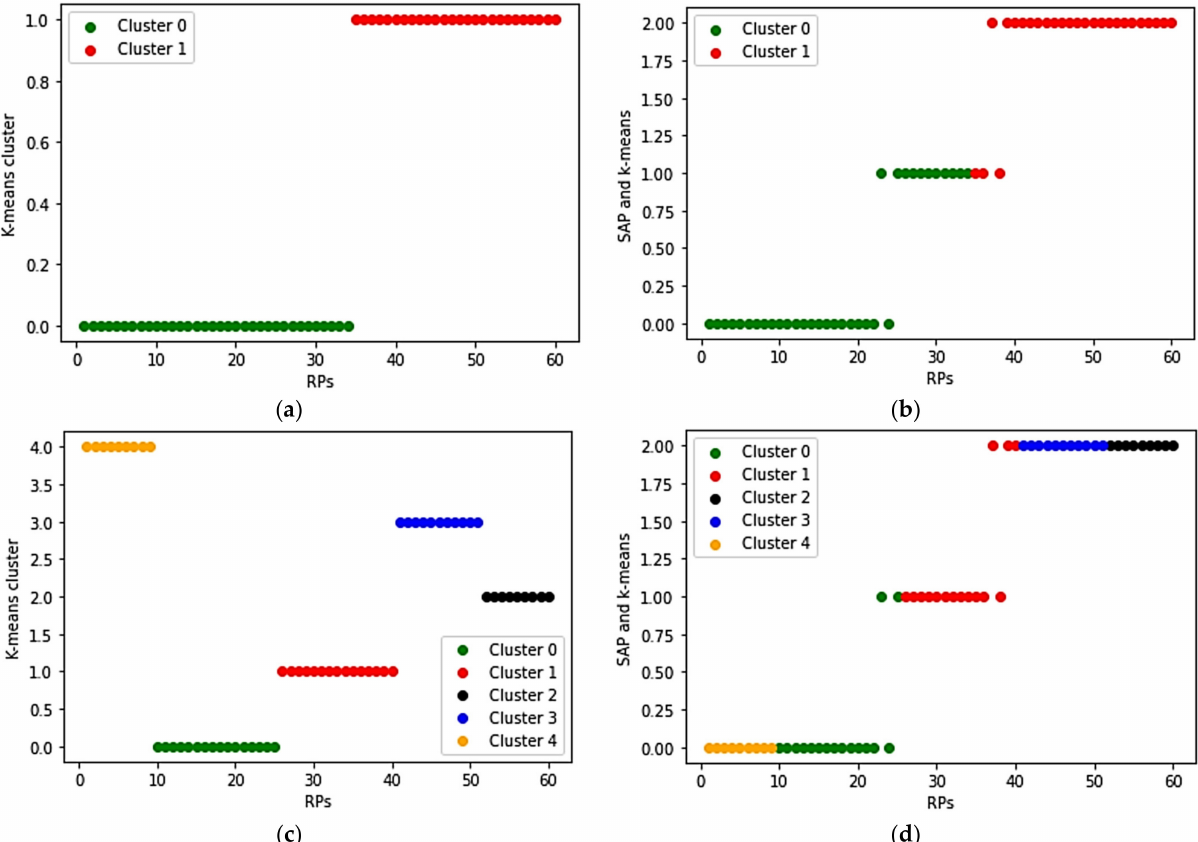
Figure 8. Comparison of k -means and SAP clusters: ( a ) k -means cluster ( k = 2); ( b ) k -means ( k = 2) compared with SAP; ( c ) k -means cluster ( k = 5); ( d ) k -means ( k = 5) compared with